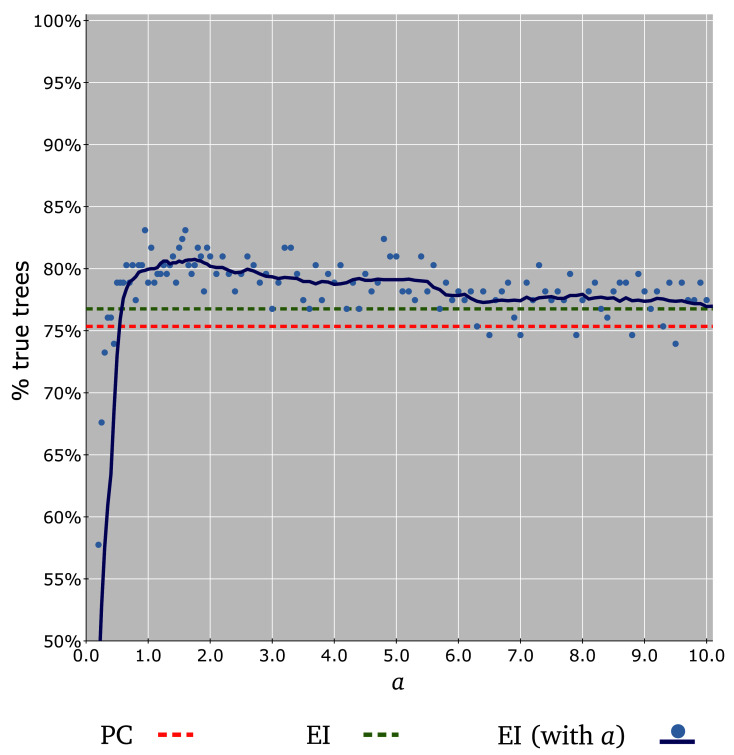
Accuracy of different
p-distance transformations for phylogenetic inference.The percentage of recovered reference trees (
y-axis ranging from 50% to 100%) is represented (light blue dots) in function of the parameter
a (
x-axis ranging from 0.0 to 10.0) in EI formula
(3). The overall trend of these dots is illustrated using a moving average (dark blue curve). Dashed lines represent the percentages of recovered reference trees obtained with the PC (red) and EI (green) transformations
(2).